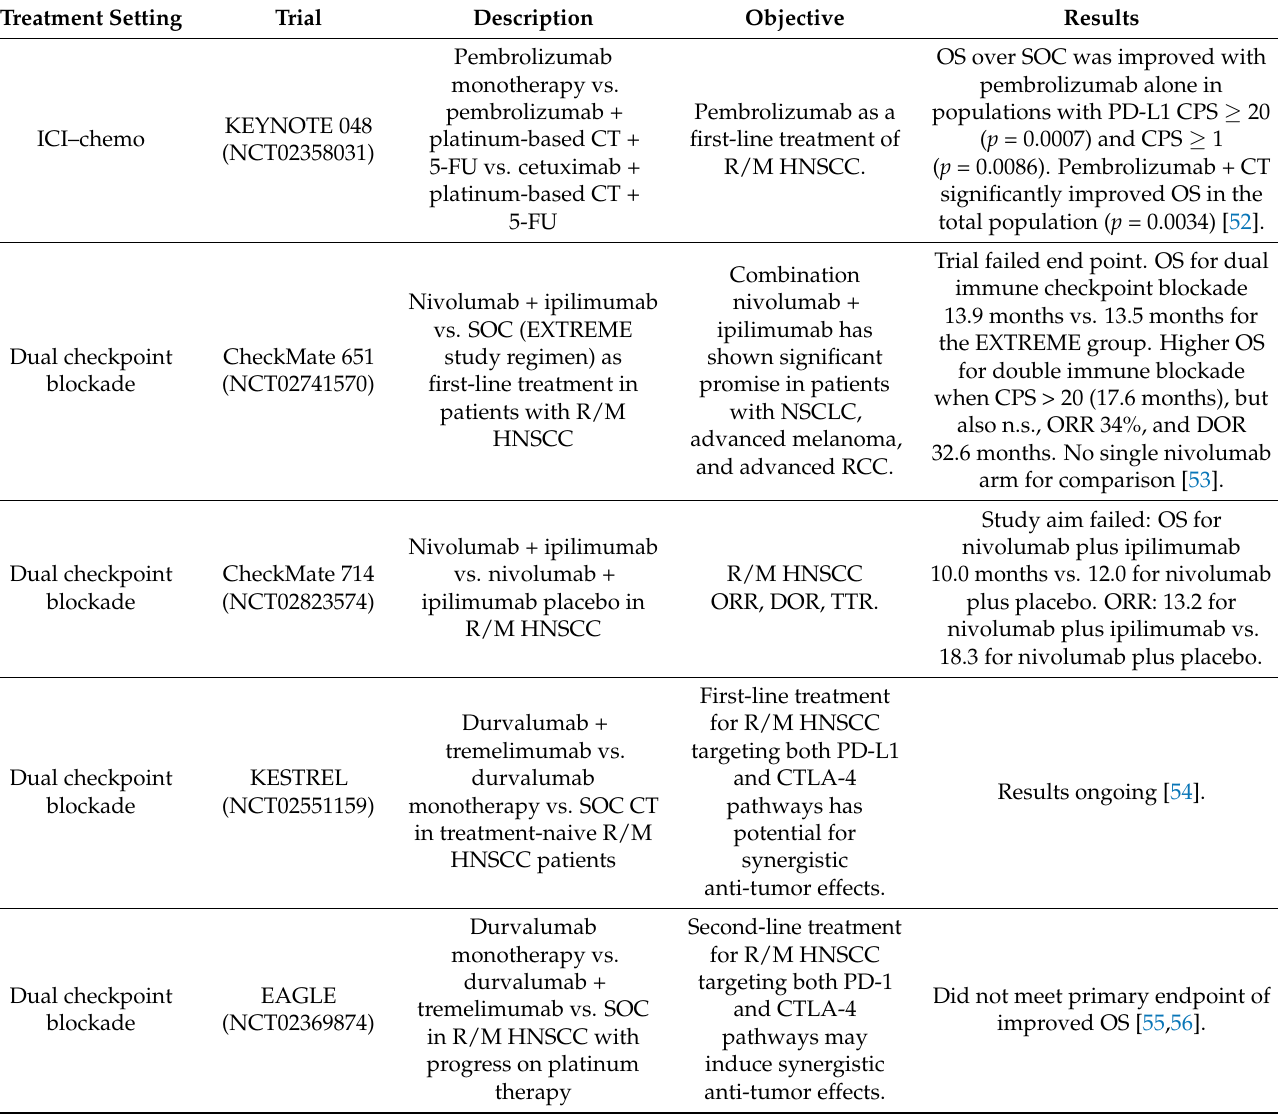
Table 1. Clinical phase III trials for the treatment of HNSCC patients with